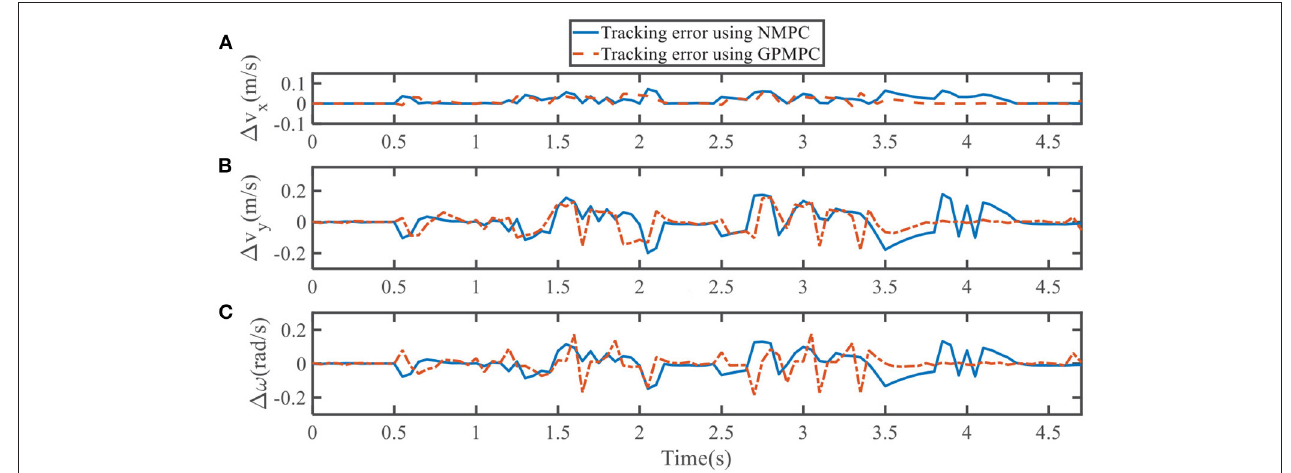
Frontiers in Neurorobotics |